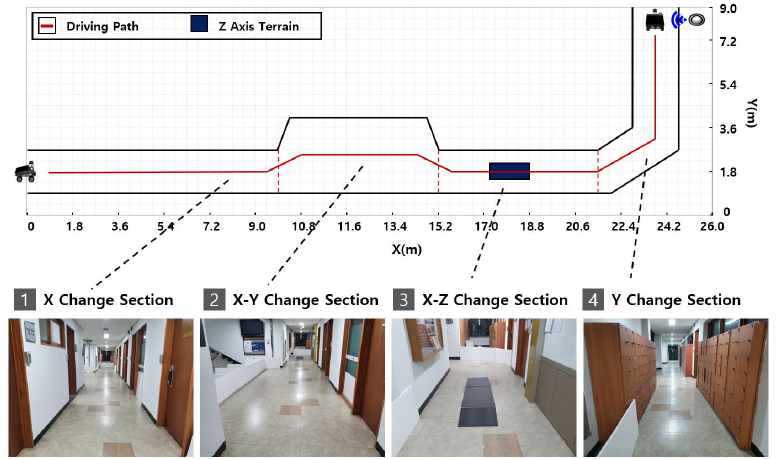
Figure 5. Conceptual diagram and views of the indoor laboratory designed in this study.